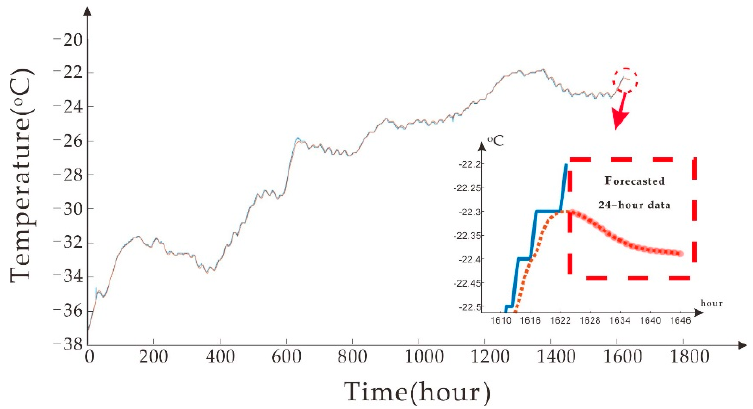
Figure 12. Bi LSTM model predicts the results of the next 24 h of data.